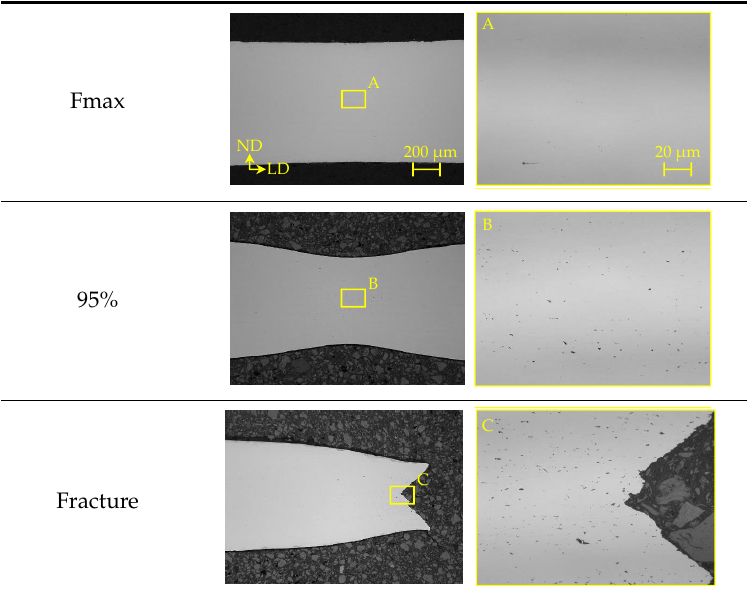
Table A8. Influence of grinding and polishing steps on the example of DP600. Table A13. Damage evolution of DP800.